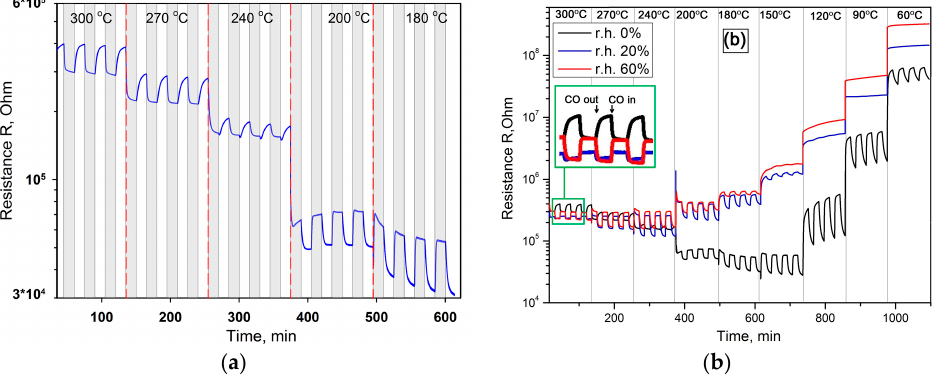
Figure 8. ( a ) Electrical response of Co 3 O 4 to the periodic change of gas phase composition from 6.7 ppm CO/air (15 min) to pure air (15 min) (0% r.h.) in dry ( a ) and humid ( b ) conditions. On part ( a ) the time periods when CO is introduced into sensor chamber are marked by gray color.